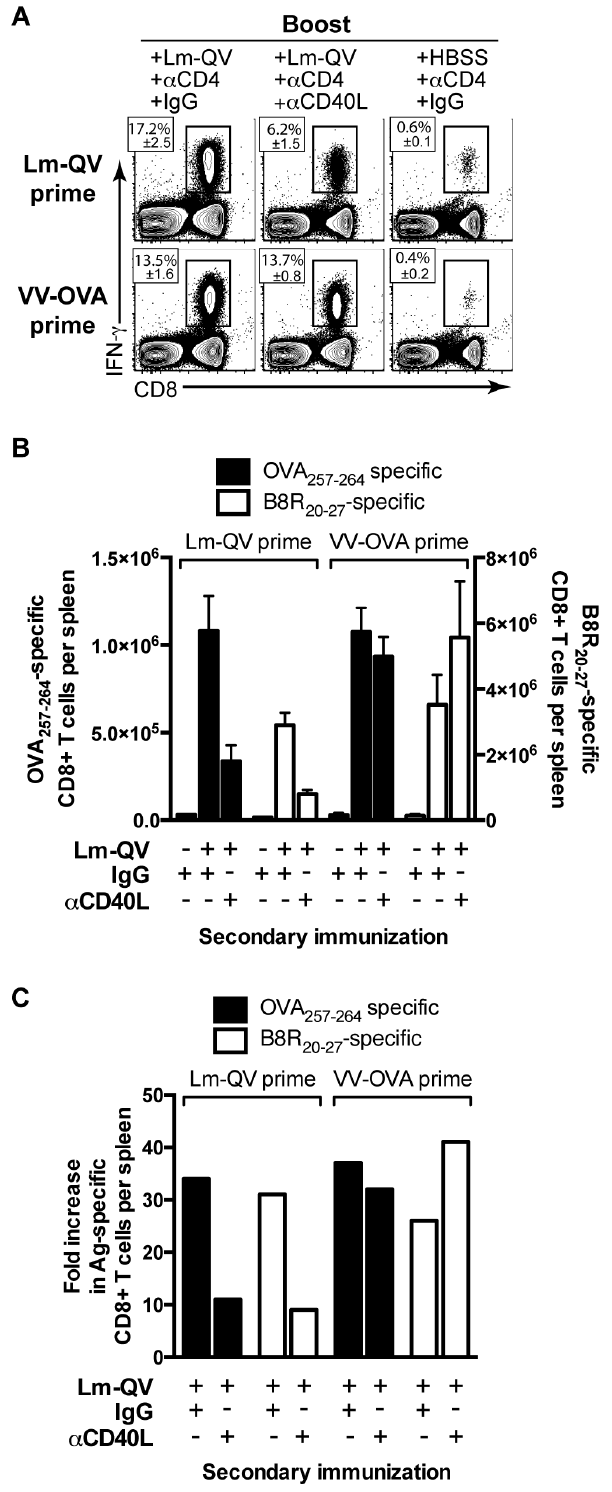
Figure 2. CD40L is required for mCD8 + T cell expansion following homologous (but not heterologous) boost, in the absence of CD4 + T cells. Mice were primed with 10 7 cfu Lm-QV or 10 6 pfu VV-OVA and boosted 21 days later with 10 5 cfu Lm-QV. Starting on day 20 (1 day pre-boost), mice were depleted of CD4 + T cells. MR1 ( a CD40L) or control antibody was administered to indicated groups during boost. OVA 257–264 -specific CD8 + T cell responses were assessed